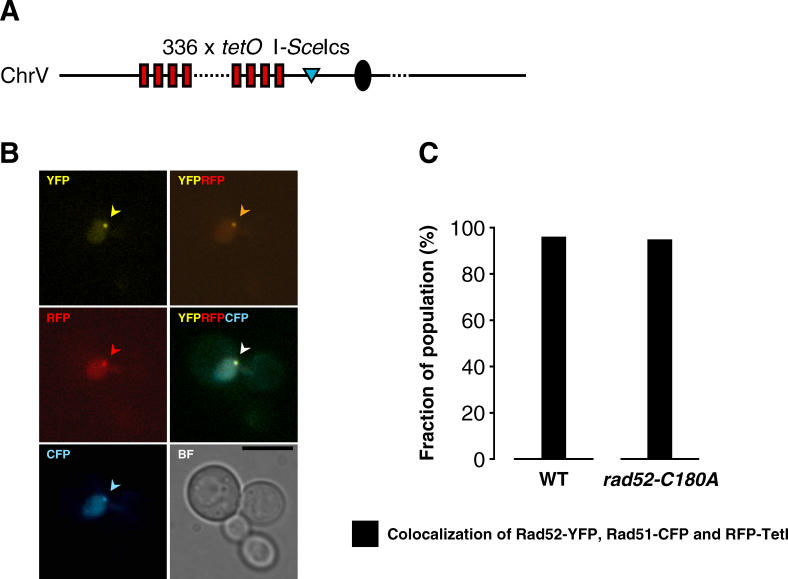
Rad51-CFP and Rad52-C180A-YFP Are Recruited to a Specific DNA DSB(A) Assay in Chromosome V for visualizing an I-SceI-endonuclease inducible DSB. Red boxes: tetO sites. Cyan triangle: I-SceI cut-site (I-SceIcs). Solid circle: centromere.(B) Localization of Rad51-CFP and Rad52-C180A-YFP foci to an I-SceI-endonuclease-induced DSB. The panels show YFP, CFP, RFP, RFP/YFP-merged, and CFP/RFP/YFP-merged, as well as a bright field image of representative cells containing Rad51-CFP and Rad52-C180A-YFP in a strain with a tetO tandem array next to an I-SceIcs on Chromosome V. The tetO tandem array is visualized by TetI-RFP as a red focus. The Rad51-CFP, Rad52-YFP, and TetI-RFP foci are marked by arrowheads. Scale bar, 3 μm.(C) Quantitative analysis of co-localization between Rad52-C180A-YFP/RFP–TetI foci and Rad51-CFP foci. The wild-type dataset is shown for comparison.